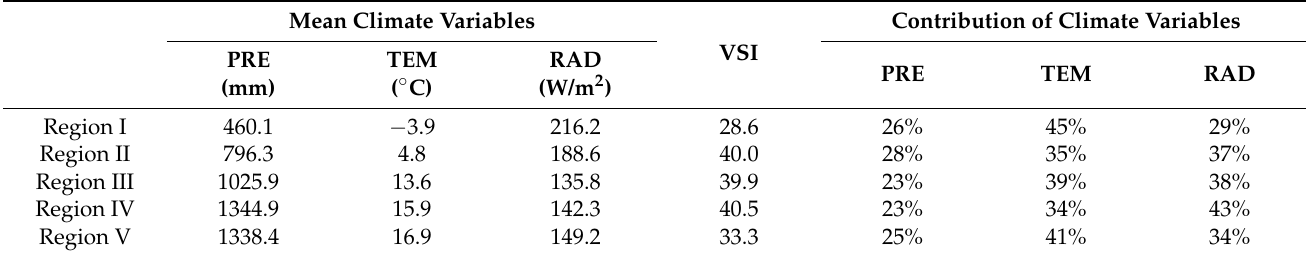
Table 1. Mean climate variables and vegetation sensitivity to climate in